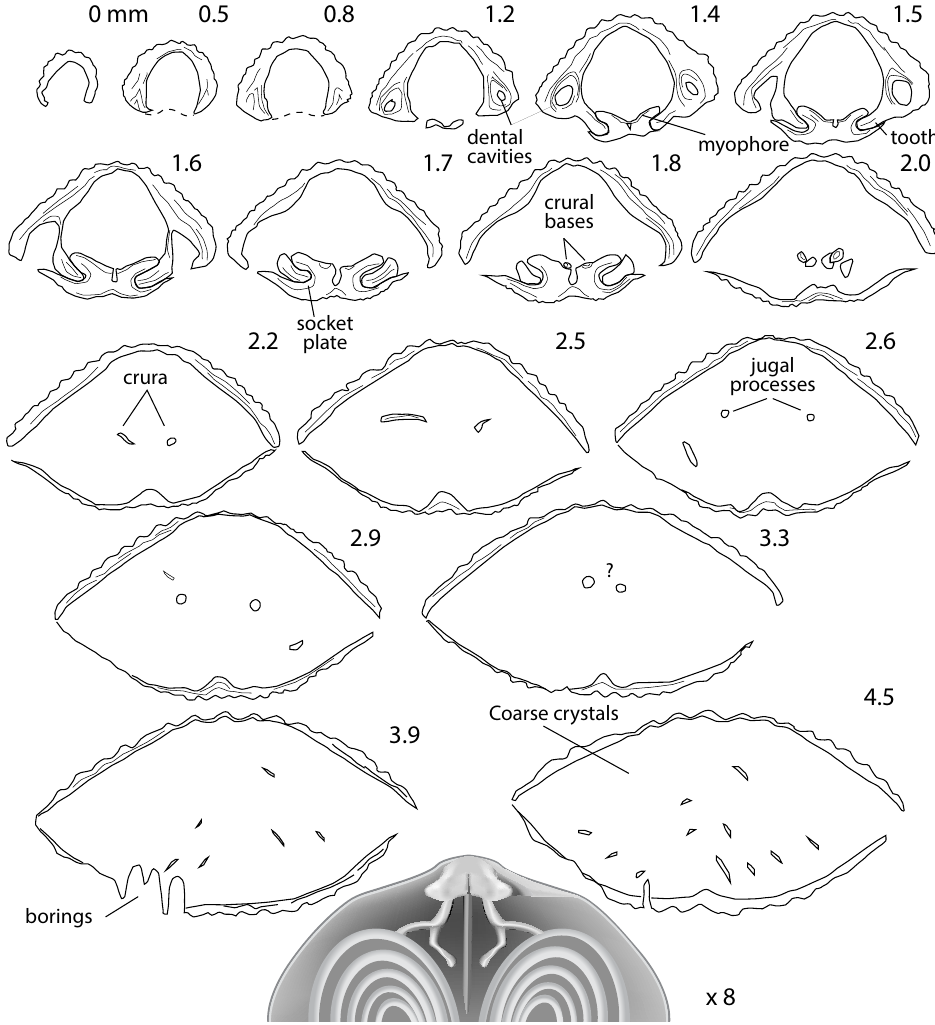
Figure 3. Clintonella aprinis. Serial sections and reconstruction of internal structures (ventral valve up) based on the sections of specimen GIT 849-15 from the local Juuru stage at Kuimetsa paemurd, Raplamaa, Estonia. Note that there is a progressively thickening lining of coarse crystals along the floor of the ventral valve that makes it difficult to see the first whorls of the